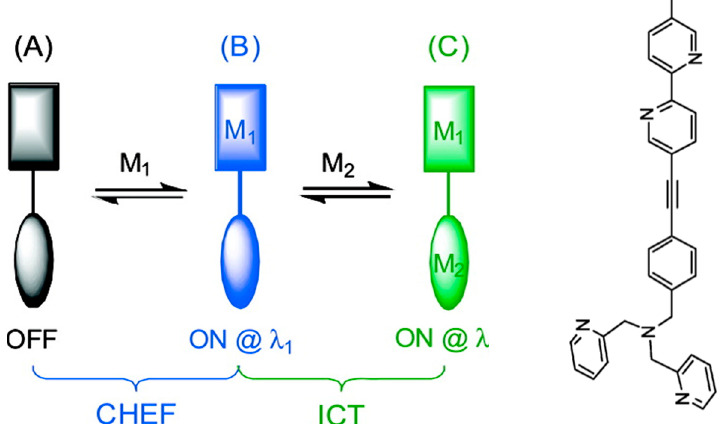
Figure 17. Schematic representation of pyridyl-containing ditoptic sensors ( A ) for both low ( B ) and high concentrations ( C ) of Zn 2+ with fluorescence enhancement at two different wavelength channels, respectively ( left ); and one of such sensors ( right ). Reprinted with permission from Reference [72]. Copyright (2008) American Chemical Society.